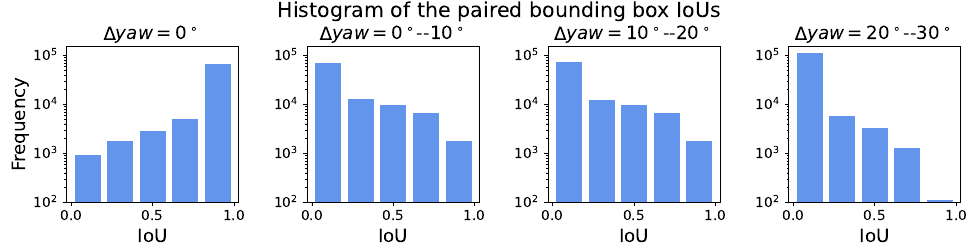
Figure 6. The histograms of the IoU values of the paired bounding boxes in the SOCD dataset and the OCD dataset. In the SOCD dataset, the larger the viewpoint differences between an image pair, the smaller the overlap of objects. By contrast, the OCD dataset had a wide distribution of IoU values because of the various viewpoint differences between the image